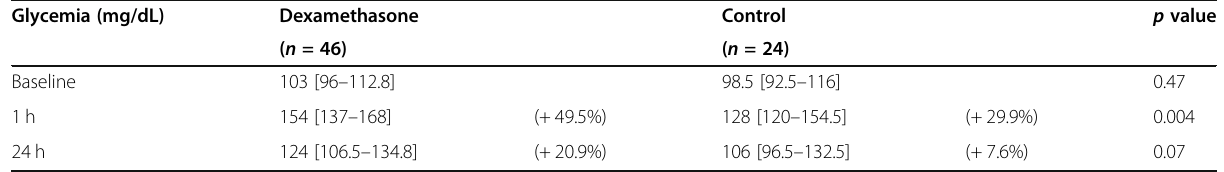
Table 5 Perioperative glycemic variations Glycemia (mg/dL) Dexamethasone